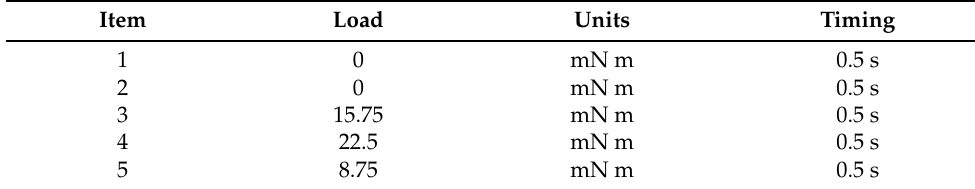
Table 3. Proposed loads for simulation and testing.